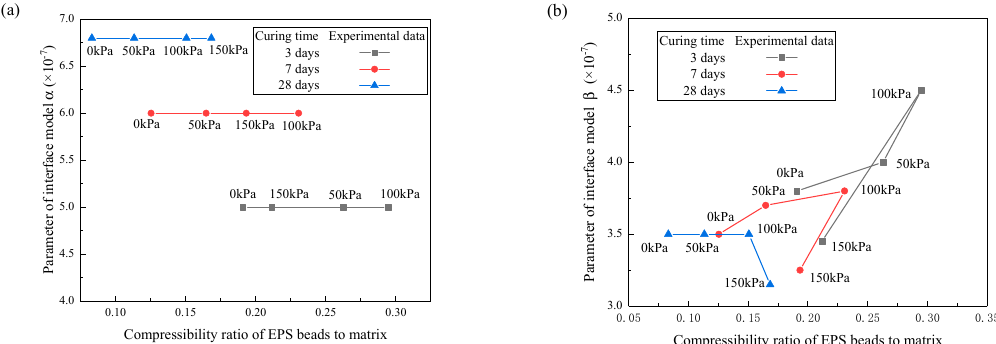
Figure 9. The compressibility ratio at different curing times ( a ) parameter of interface model α ; ( b ) parameter of interface model β .